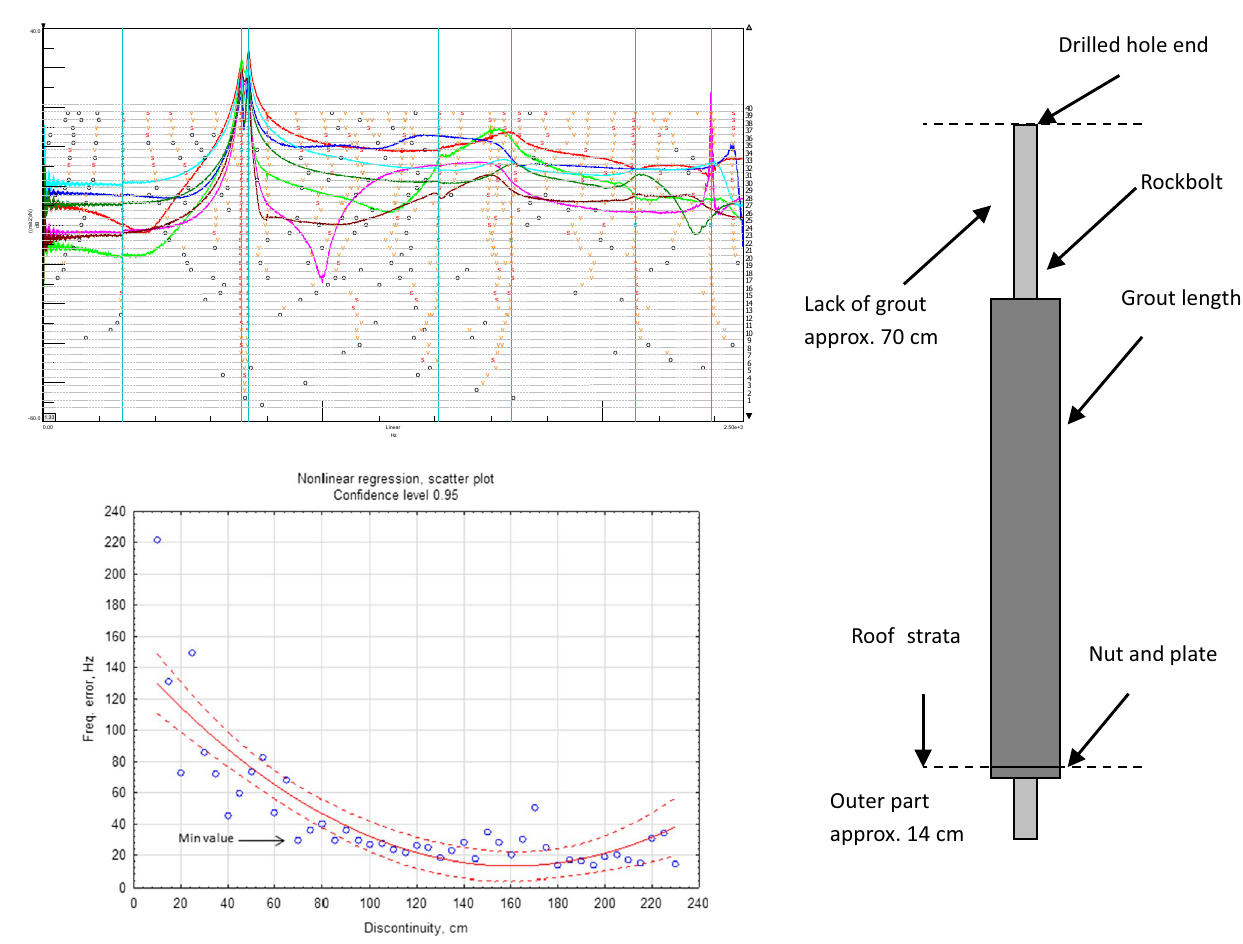
Fig. 13 The results of estimation of the grout length: the character- istics of the transfer function for the analyzed case, the vertical axis of the chart—inertance, in (m/s 2 )/N, the horizontal axis—frequency,